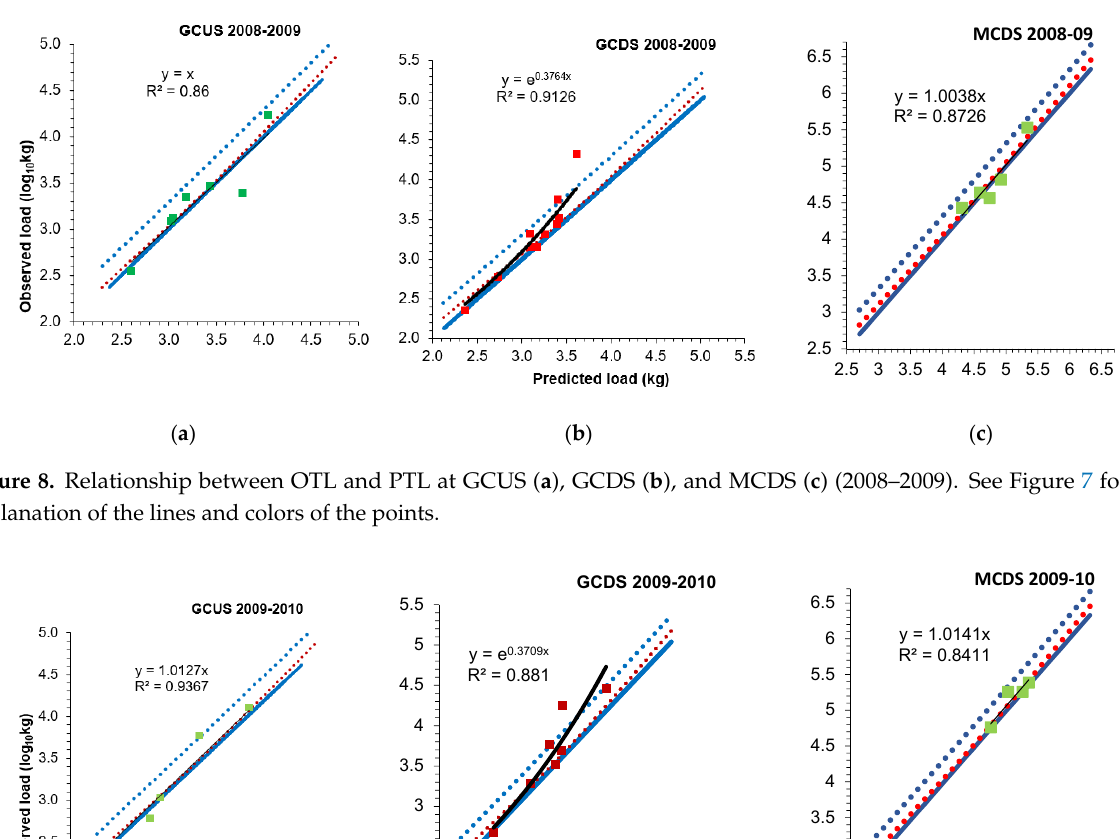
Figure 7. Relationship between OTL and PTL at GCUS ( a ), GCDS ( b ), and MCDS ( c ) (2003–2008). The dark blue line in each graph is the best fit (1:1) line for the undisturbed relationship data. The red dashed line is the 95% confidence limit and the blue dashed line is the 95% prediction limit of the 1:1 line. The black line is the fitted line for the events in each year. Each event is shown as marker point in the graph. The markers are colored green when the events are evenly dis- tributed around the best fit line (no disturbance in the catchment) and red otherwise.